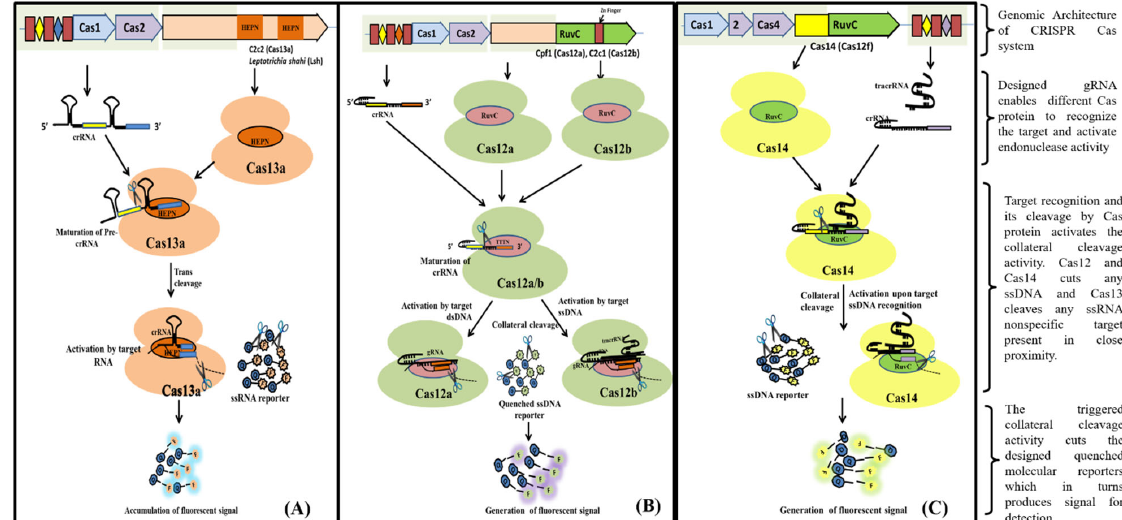
Figure 4. Schematic diagram showing various steps from Cas endonuclease formation to activation of its collateral cleavage activity. ( A ) Mechanism of CRISPR/Cas13 cis ‐ activation upon target RNA detection activating it for collateral ‐ cleavage of non ‐ target ssRNA. ( B ) Mechanism of cis ‐ activation of CRISPR/Cas12a and CRISPR/Cas12b by target dsDNA and ssDNA respectively. Both CRISPR/Cas12a and Cas12b trans ‐ cleave non ‐ target ssDNA upon cis ‐ activation. ( C ) Mechanism of CRISPR/Cas14 (Cas12f) cis ‐ cleavage activation by target ssDNA detection and trans ‐ cleavage activation for non ‐ target ssDNA upon cis ‐ activation.